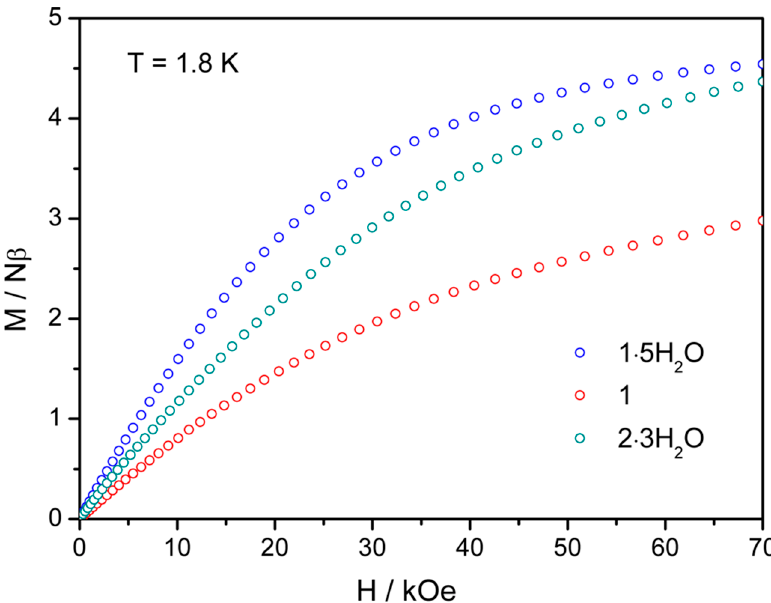
Figure 6. Field dependence of magnetization at 1.8 K for 1·5H 2 O , 1 and 2·3H 2 O .